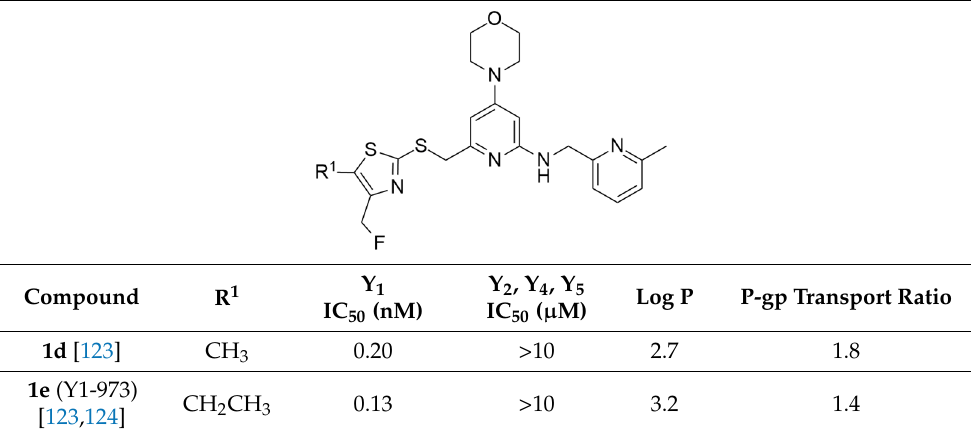
Table 4. Structure and in vitro properties of compound 1d and 1e (Y1-973).